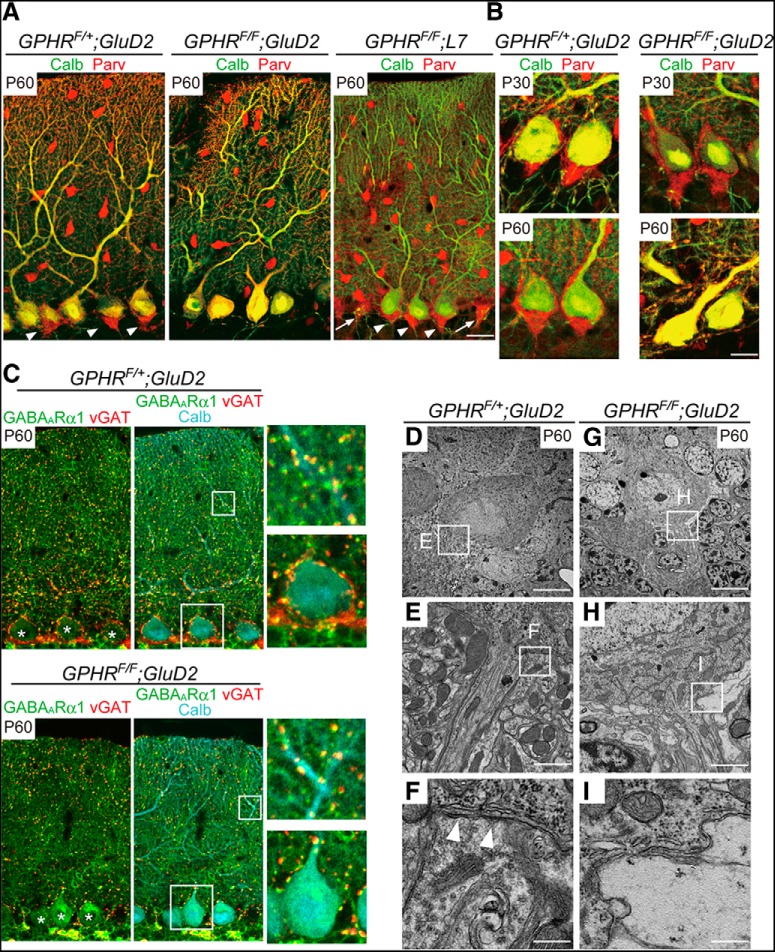
Disappearance of Pinceau structures in GPHRF/F;GluD2-Cre mice. A, Double immunofluorescence for calbindin (Calb; green) and parvalbumin (Parv; red) in the PC layer from GPHRF/+;GluD2-Cre, GPHRF/F;GluD2-Cre, and GPHRF/F;L7-Cre mice at P60. Arrowheads indicate Pinceau structures. Arrows indicate Pinceau structures without PCs. Scale bar: 20 µm. B, Higher magnification images of Pinceau structures. At P30, the Pinceau structures form cone-shaped structures in both GPHRF/+;GluD2-Cre and GPHRF/F;GluD2-Cre mice, whereas this structure is absent at P60 for GPHRF/F;GluD2-Cre mice. Scale bar: 20 µm. C, Triple immunofluorescence for GABAA Rα1 (green), vGAT (red) and calbindin (cyan) of the molecular layer at P60. GABAA Rα1 and vGAT colocalized on PC somata and dendrites in GPHRF/+;GluD2-Cre mice, whereas it decreased in PC somata, but not in the distal dendrites of GPHRF/F;GluD2-Cre mice. Boxed regions are enlargements and presented in the right panels. Asterisks indicate PC somata. Scale bar: 20 µm. Electron micrographs of PC soma (D, G) and AIS (E, F, H, I) in GPHRF/+;GluD2-Cre (D−F) and GPHRF/F;GluD2-Cre mice (G−I) at P60. Boxed regions in D, G are enlarged in E, H, respectively. Boxed regions in E, H are enlarged in F, I, respectively. Disruption of BC axon terminal and Bergman glial processes in the Pinceau area of GPHRF/F;GluD2-Cre mice (D–F). Scale bars: 5 µm (A, D), 1 µm (B, E), 500 nm (C, F). Arrowheads indicate an active zone. For A−I, three mice per genotype were used; n = 5 sections per mouse for each genotype; representative images are shown.